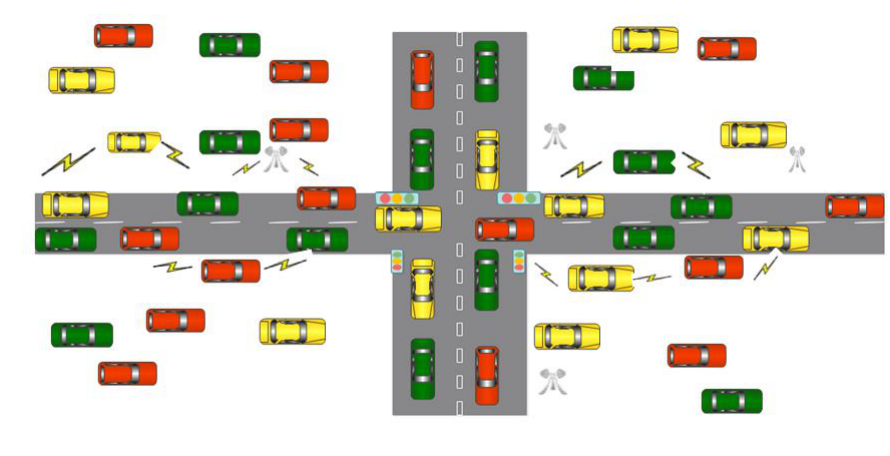
Figure 2. Reference